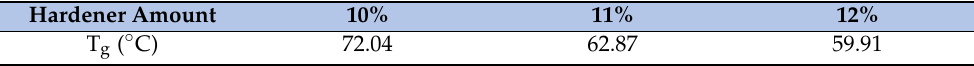
Table 2. Glass transition temperatures for three ratios of hardener to epoxy resin.